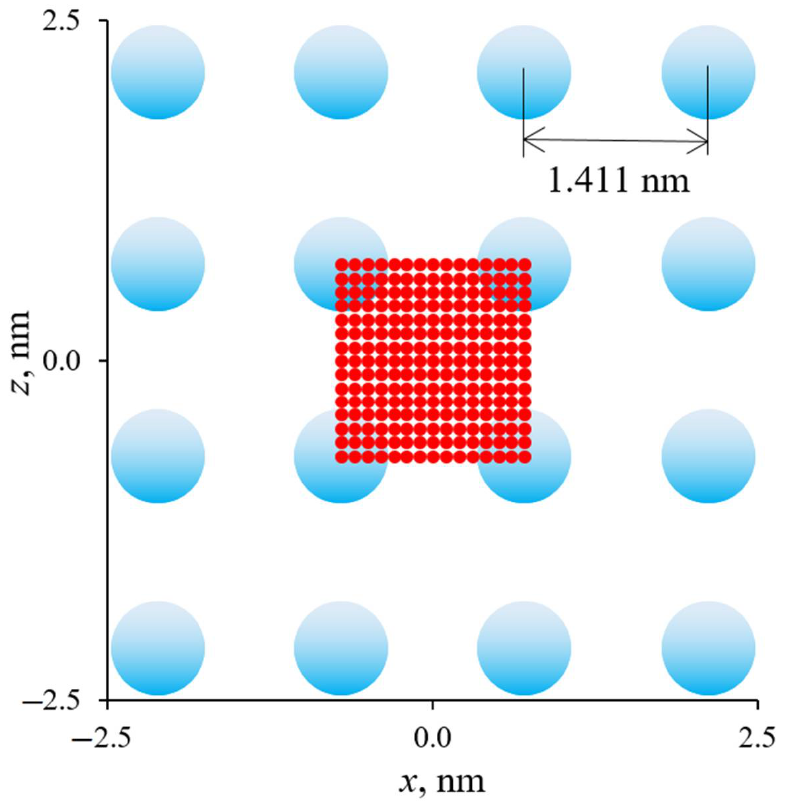
Figure 2. The initial position of the conditional beam of incoming particles (red color) relative to the considered C 60 fullerite (blue color) in projection on the xz -plane.